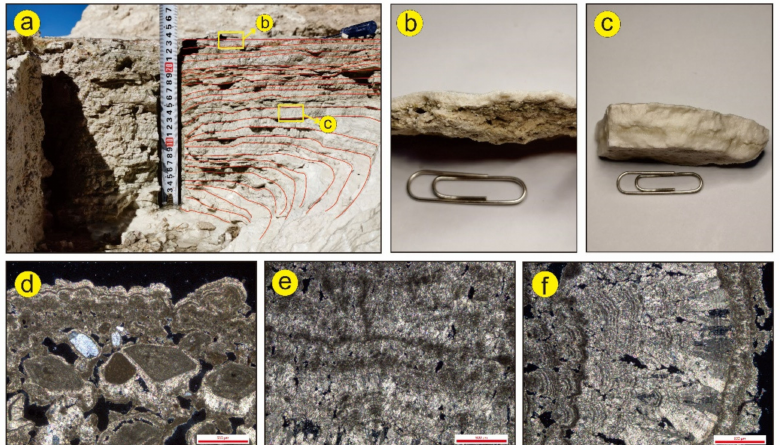
Figure 4. Textures of travertine of Zabuye Salt Lake. ( a ) Travertine profile with good stratification. ( b ) Sample at top of profile (ZD01) with higher porosity. ( c ) Dense middle section sample (ZD12). ( d ) Clastic nuclei are composed of travertine clasts, quartz, and feldspar grains. ( e ) Generation growth relationship exists between base of microsparry and micrite. ( f ) Crystalline dendrite textures showing wavy and banded internal zonations. The length of the red line segment is 500 µ